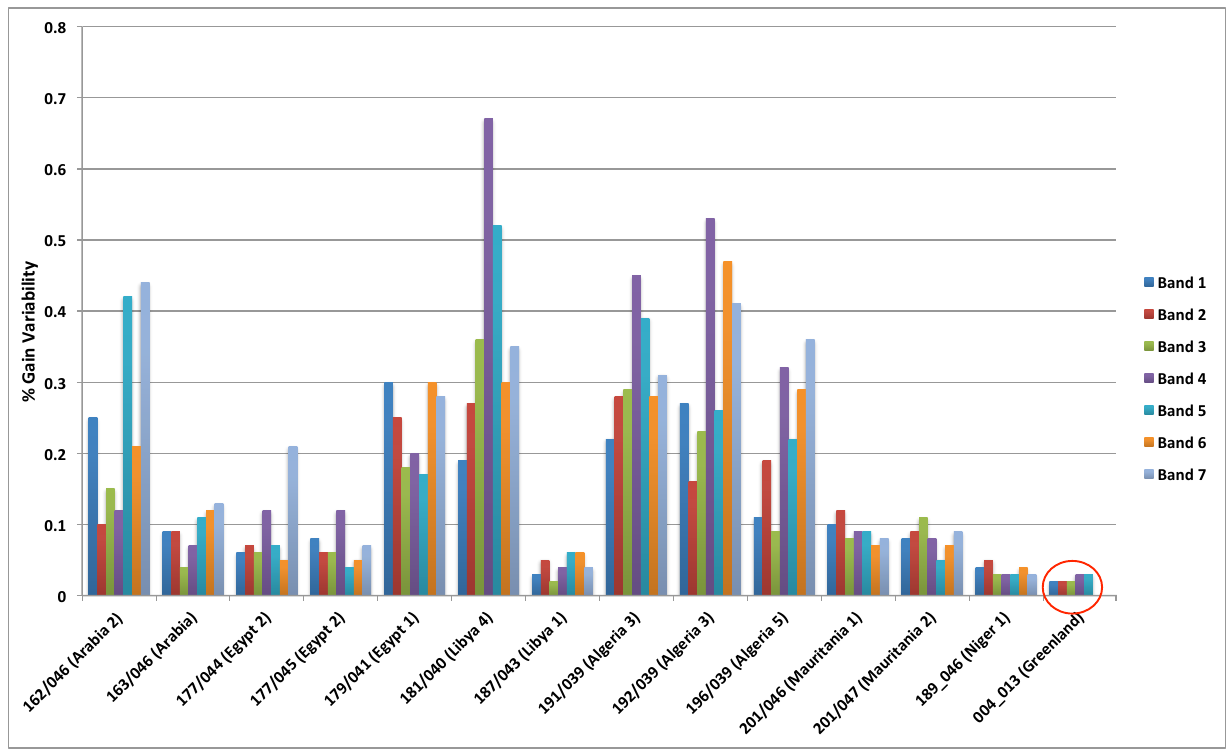
Figure 16. Results showing the side slither-derived gain variability for several of the original sites included in Section 2.3 and the additional Niger and Greenland sites. Note that the study in Section 2.3 used only the center 2 arrays for the sensor model while this study incorporated all 14 arrays into its sensor